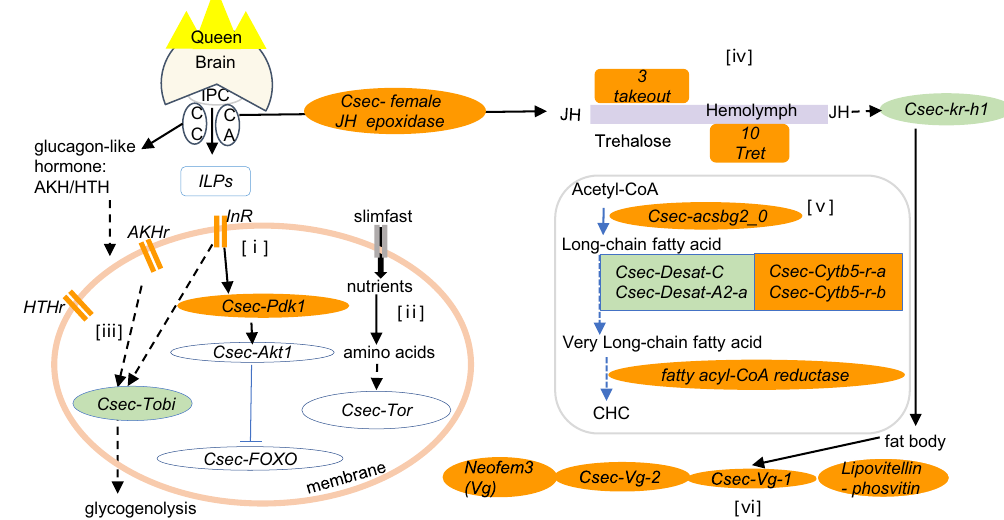
Fig. 5 Schematic representation of the queen central module (QCM). Shown are genes, which we found co-expressed in the QCM (orange color) and in other queen modules (greenish color) across the nutrient-sensing pathways (i) IIS and (ii) TOR, (iii) neuro-hormonal regulation of metabolic processes, (iv) JH signaling (including trehalose transport) (upper part), (v) CHC production, and (vi) vitellogenesis. The left part of the fi gure depicts gene regulatory pathways related to neuroendocrine and IIS/TOR signaling while the right parts concentrate on fecundity- and CHC-related processes. Both parts are connected by transport processes via the hemolymph. The general gene and pathway relationships are based on studies of D. melanogaster , mosquitos, nonsocial cockroaches and social insects (for details, see main text). Circles/double bars represent genes, squares represent gene ‘ clusters ’ , arrows indicate activation, and stop bars denote repression. Solid versus dashed lines represent direct versus supposed indirect interactions requiring further investigation. IPC insulin producing cells, CC corpus cardiacum, CA corpora allata. For further information and gene names, see